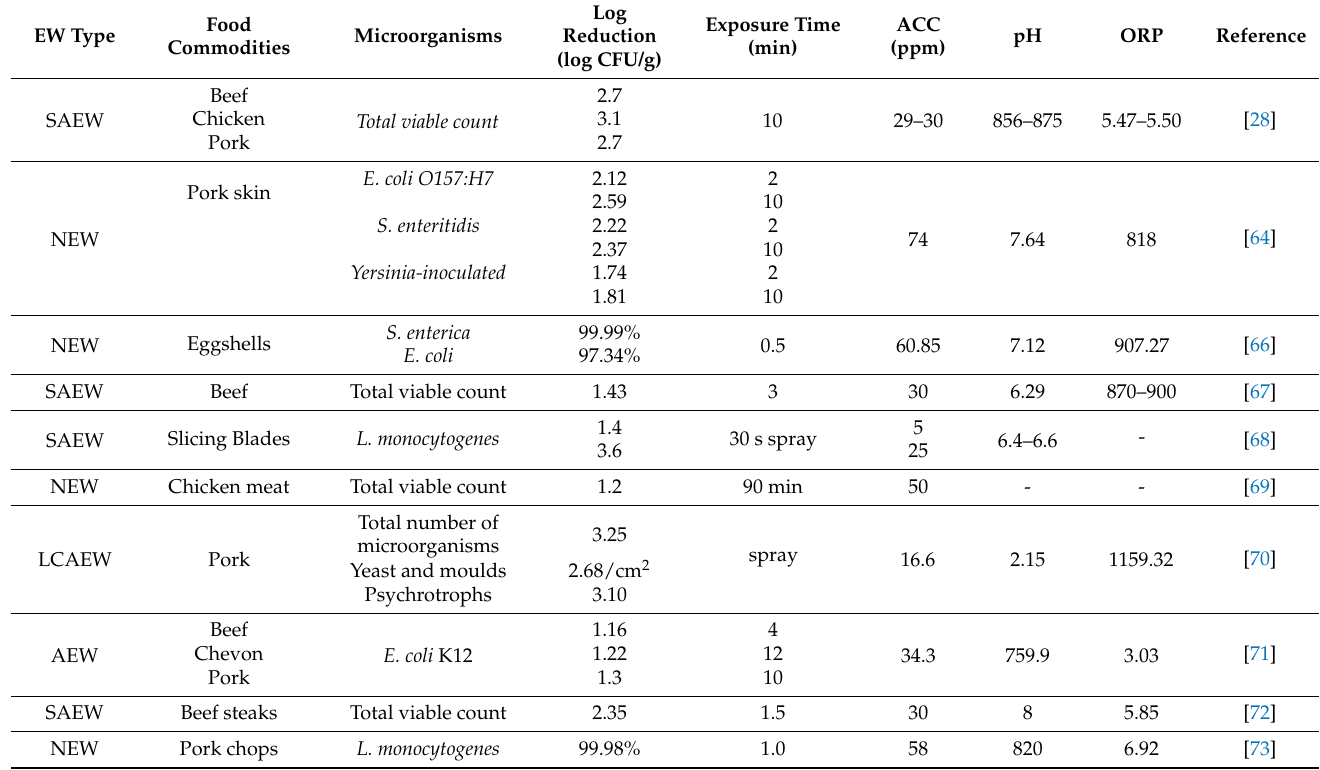
Table 2. Application of EW against various microorganism in poultry and